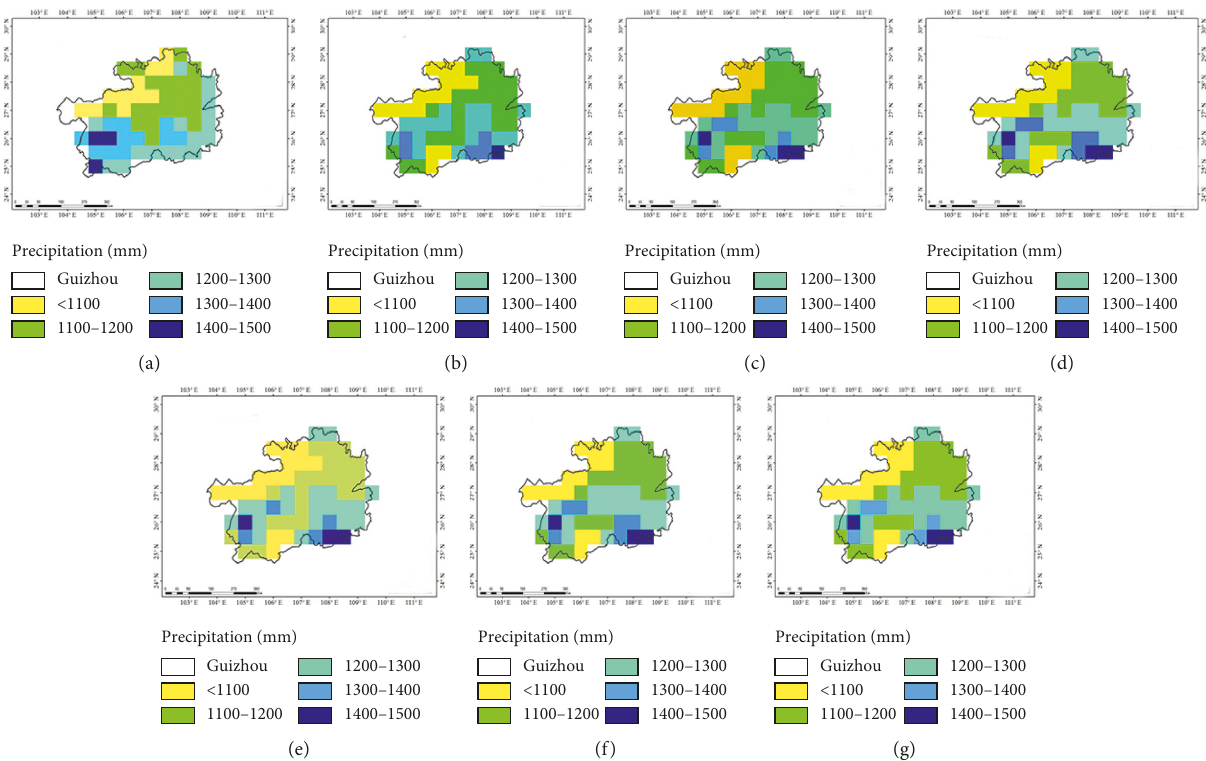
Figure 5: Spatial distribution of precipitation. (a)–(g) represent measure, GFDL-ESM2M, IPSL-CM5A-LR, HadGEM2-ES, NorESM1-M, MIROC-ESM-CHEM, and the mean of the five models, respectively.